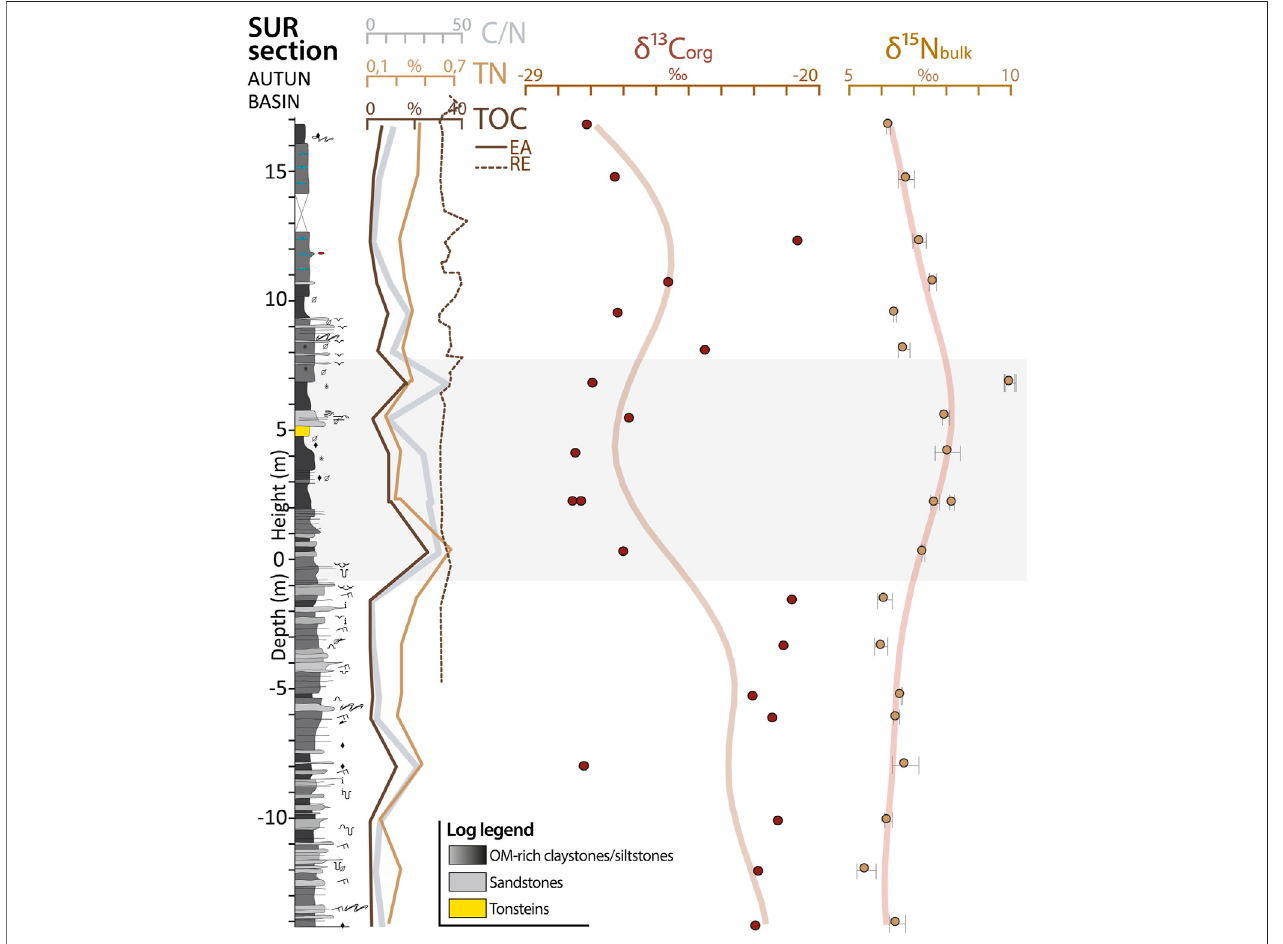
FIGURE 6 | Sedimentary section of the SUR, SUR-1 and SUR-2 cores and outcrop (Autun Basin) and organic signal evolution (total organic carbon TOC, total nitrogen TN, C/N atomic ratio, δ 13 C org and δ 15 N bulk variations). The log caption is displayed on Figure 2 . RE, Rock-Eval pyrolysis.